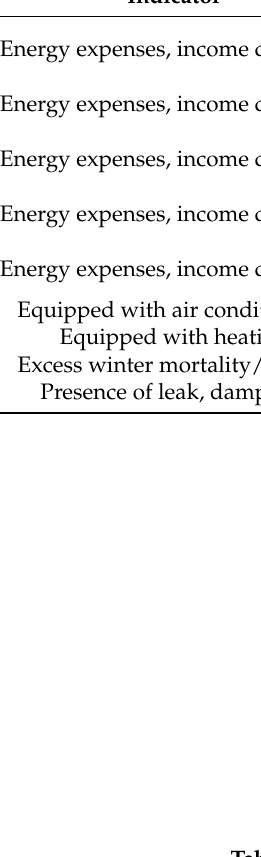
Table 3. Multidimensional ways to measure fuel poverty—selected